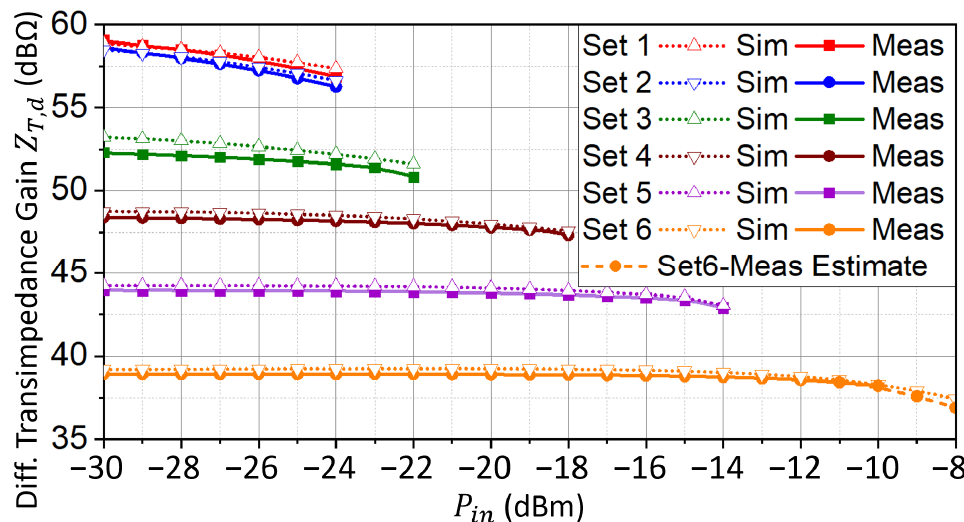
Table 2. Simulated and measured gain, bandwidth and IP 1dB of the TIA.